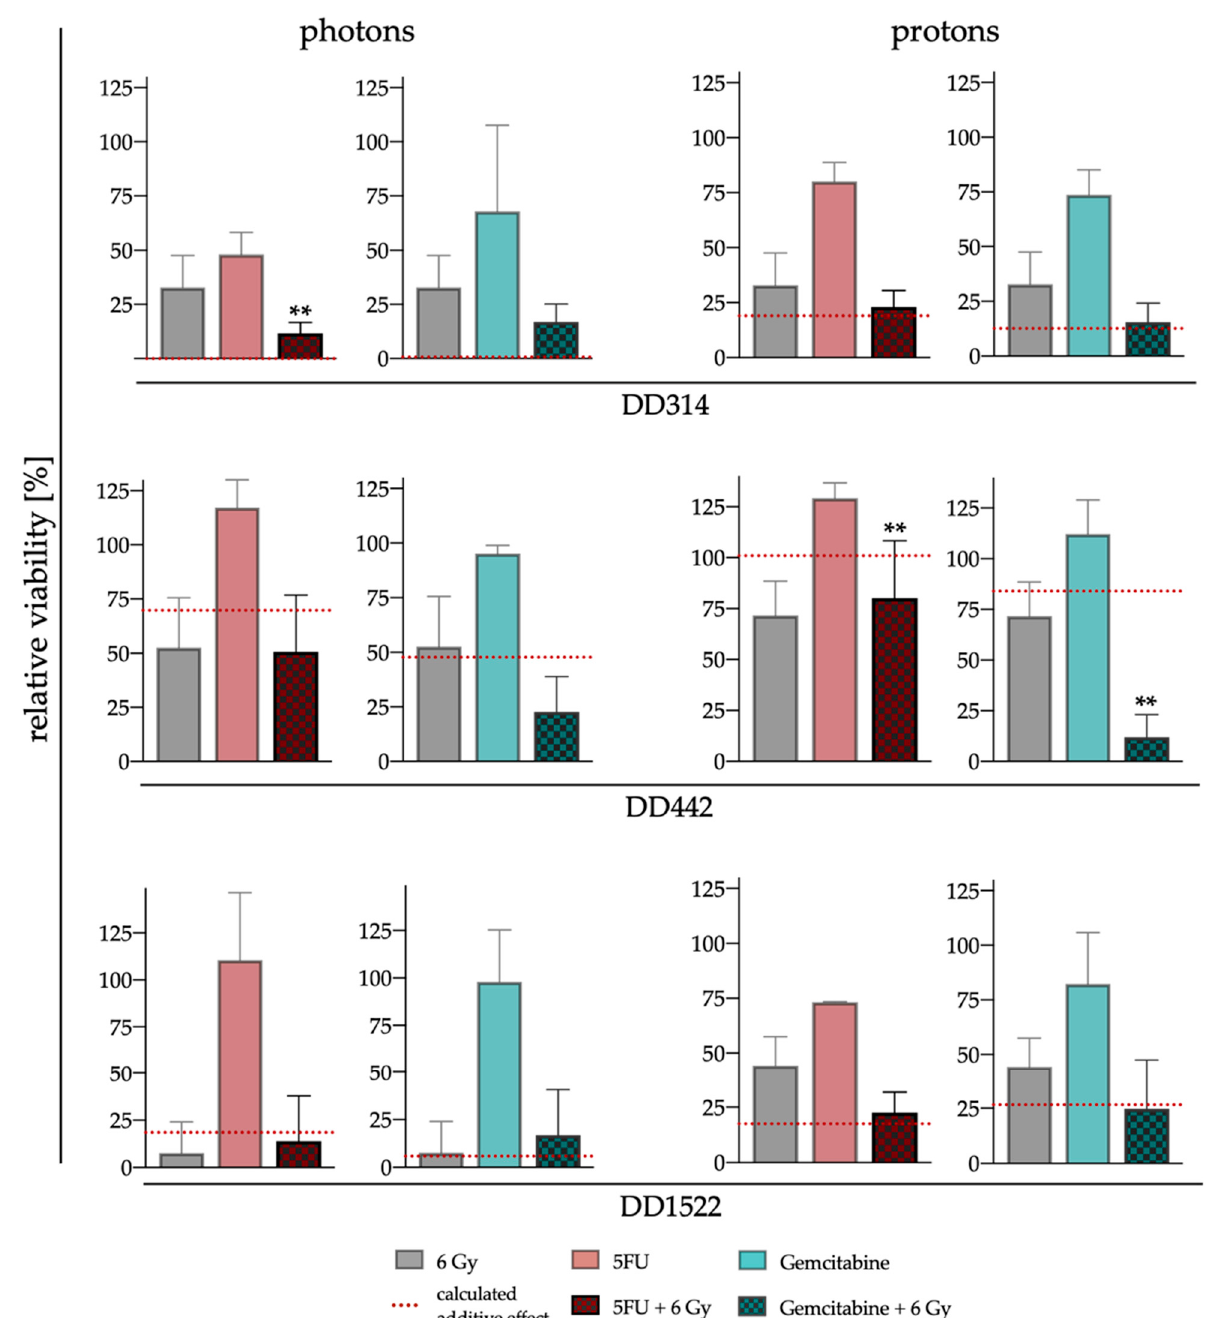
Figure 4. Response of PDOs to RCT with 6 Gy photons or protons. Relative viability was measured on day 13 after RCT with either gemcitabine or 5FU in combination with 6 Gy photon or proton irradiation, respectively ± SD. The red dotted line shows the sum of effects after single treatments (to evaluate if combined effects are synergistic, generalized estimating equation were used, ** p < 0.01).